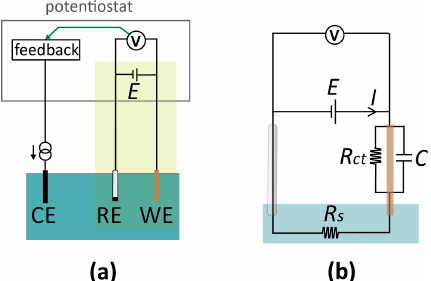
Figure 2. ( a ) Schematic of a conventional electrochemical cell for voltammetric measurement. The cell consists of three electrodes, termed the working (WE), reference (RE), and counter electrode (CE), immersed in the electrolyte solution. A potential, E , is applied to the WE with respect to the RE. If the current through the RE would be high enough to cause a potential shift, a CE is introduced to minimize the current through the RE. At low currents, it is instead possible to operate with a two-electrode configuration and eliminate the CE altogether (highlighted in green), simplifying the detection circuitry. ( b ) Equivalent circuit diagram of a two-electrode setup. R s : solution resistance; R ct : charge-transfer resistance at the WE; C: electrical double layer capacitance at the WE. This circuit treats the RE as ideally non-polarizable.